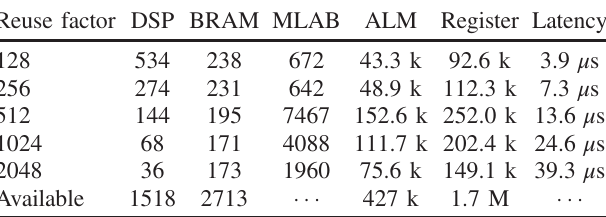
TABLE IV. The required FPGA resources and corresponding latency for the NN algorithm are shown for three possible implementations corresponding to various reuse factors. In addition to design parameters, the maximum available resources are shown for an Intel Arria 10 benchmark FPGA. Memory logic array blocks (MLABs) are configured from ten ALMs and hence no device maximum is